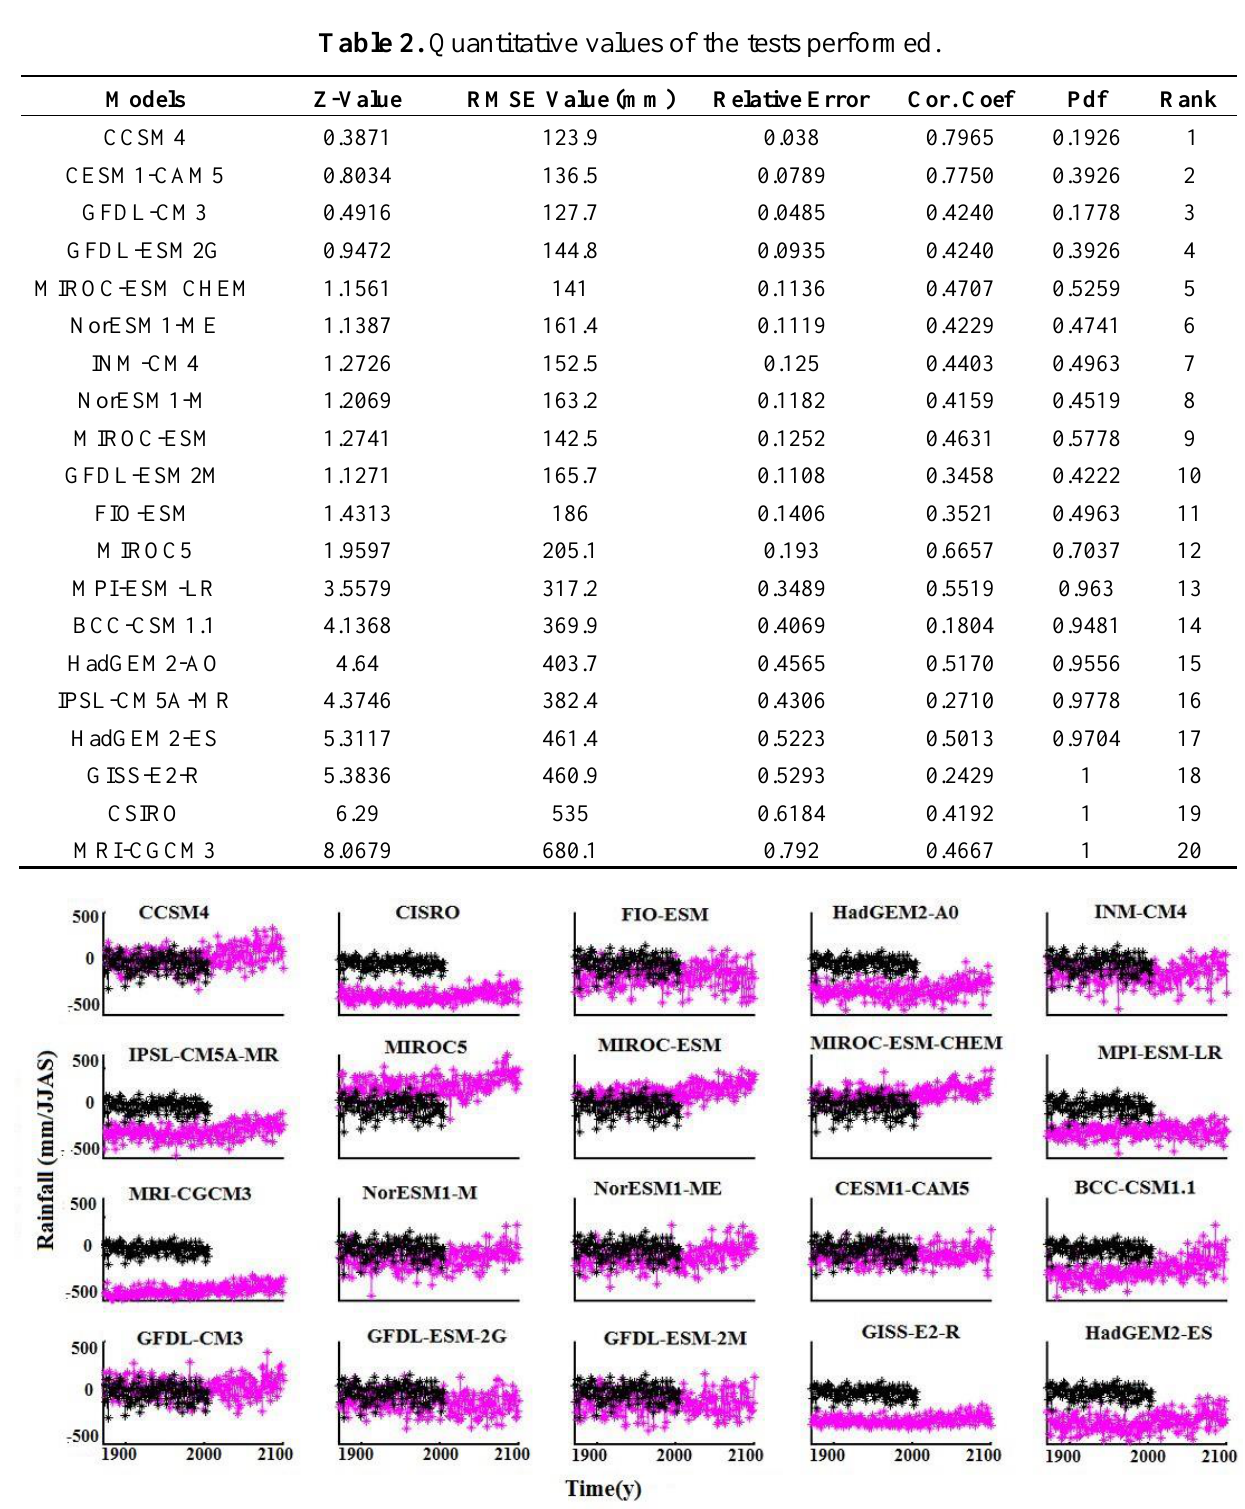
Figure 3. Long-term trend in AISMR. Observations (black) are for the time period of 1871–2005 and model outputs (pink) are for the time period of